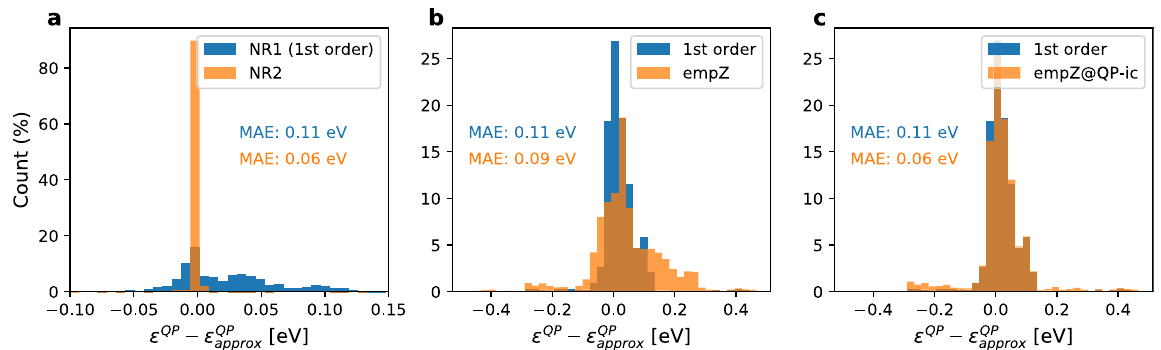
Fig. 6 Newton – Raphson and the empirical Z method. a The error distributions for fi rst-order Newton – Raphson (NR1) (blue) and second- order Newton – Rahpson (NR2) (orange). NR1 is equivalent to solving the linearized QP equation. b The NR1 distribution from a is again shown in blue for comparison. The orange distribution shows the error for the empirical empZ scheme. c The NR1 distribution is again shown in blue. The orange distribution is the error when the empZ scheme is applied only to the QP-ic states.